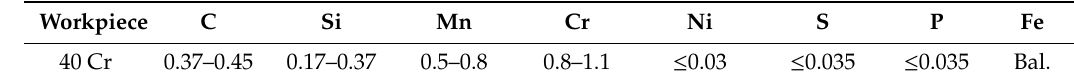
Table 4. Composition of workpiece material 40Cr